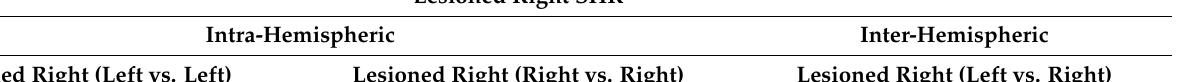
Table 4. Intra- and inter-hemispheric correlations between brain aminopeptidase activities; be- tween plasma aminopeptidase activities; between plasma aminopeptidase activities versus brain aminopeptidase activities and between aminopeptidase activities versus systolic blood pressure (SBP) in lesioned right spontaneously hypertensive rats (SHR). Lesioned Right SHR Intra-Hemispheric Inter-Hemispheric Lesioned Right (Left vs. Left) Lesioned Right (Right vs. Right) Lesioned Right (Left vs. Right)